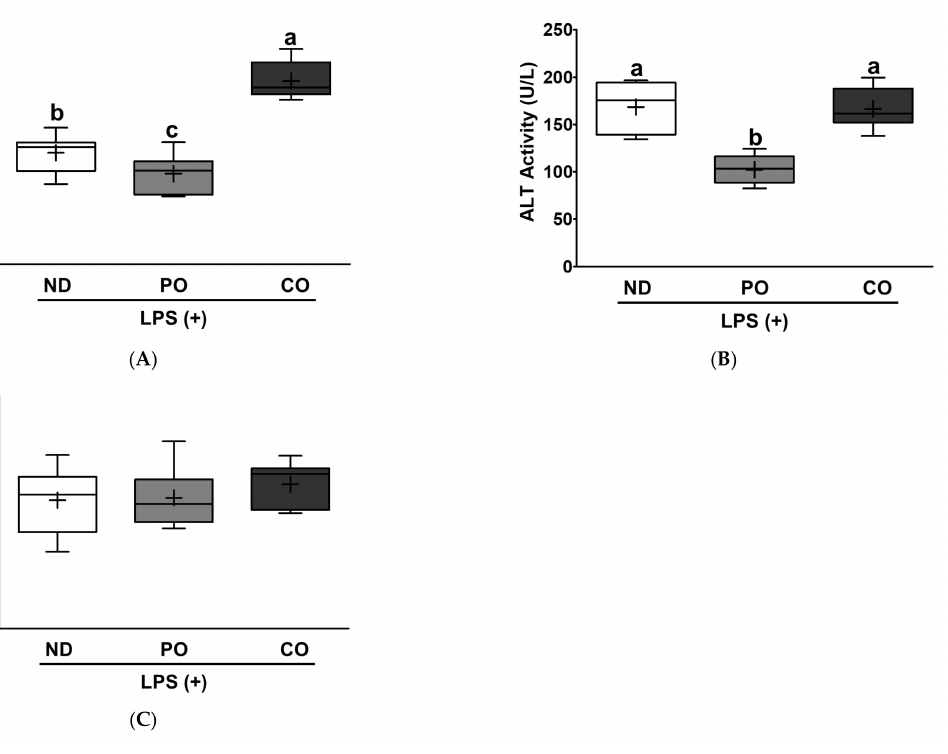
Figure 6. Partial replacement of dietary fat with PO or CO and LPS challenge on lipid contents and histology analysis in liver. Mice were fed either an ND or an ND partially replaced with PO or CO for 12 weeks and then treated with LPS (1 mg/kg) for 24 h ( n = 8 per group). ( A ) Hepatic triglyceride (TG) levels; ( B ) hepatic total cholesterol (TC) levels; ( C ) H&E staining of liver tissue (bar = 50 μ m, 20 × magnification); ( D ) histological scores of liver tissue. Values are presented as box and whisker plots representing 8 mice per group. Data were analyzed using one-way ANOVA followed by Tukey’s post hoc test. Black arrow represents lipid droplet and red arrow represents lobular inflammation. Labeled means without a common letter differ ( p < 0.05).